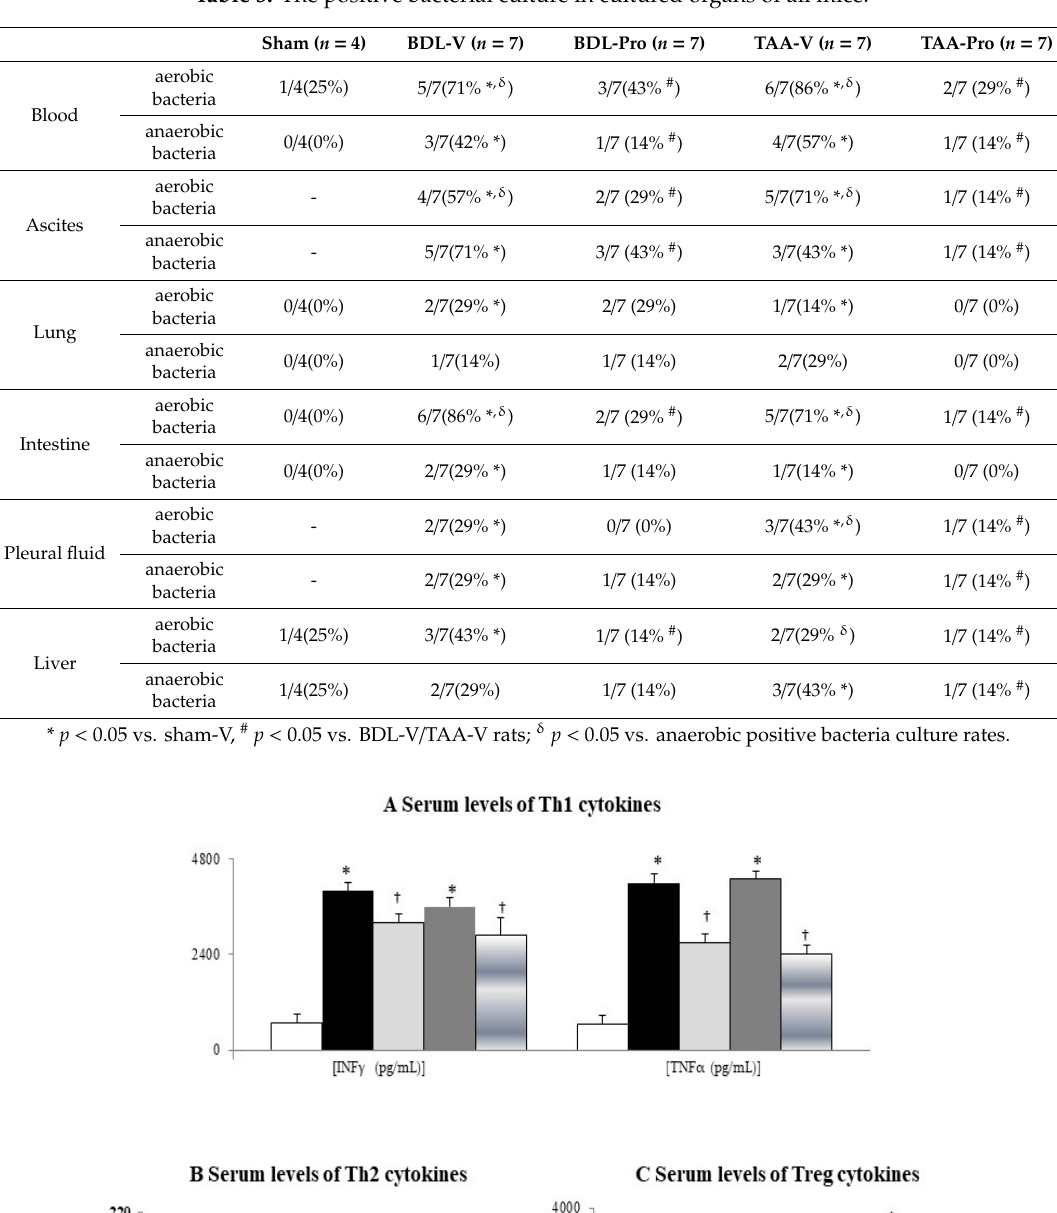
Table 3. The positive bacterial culture in cultured organs of all mice.